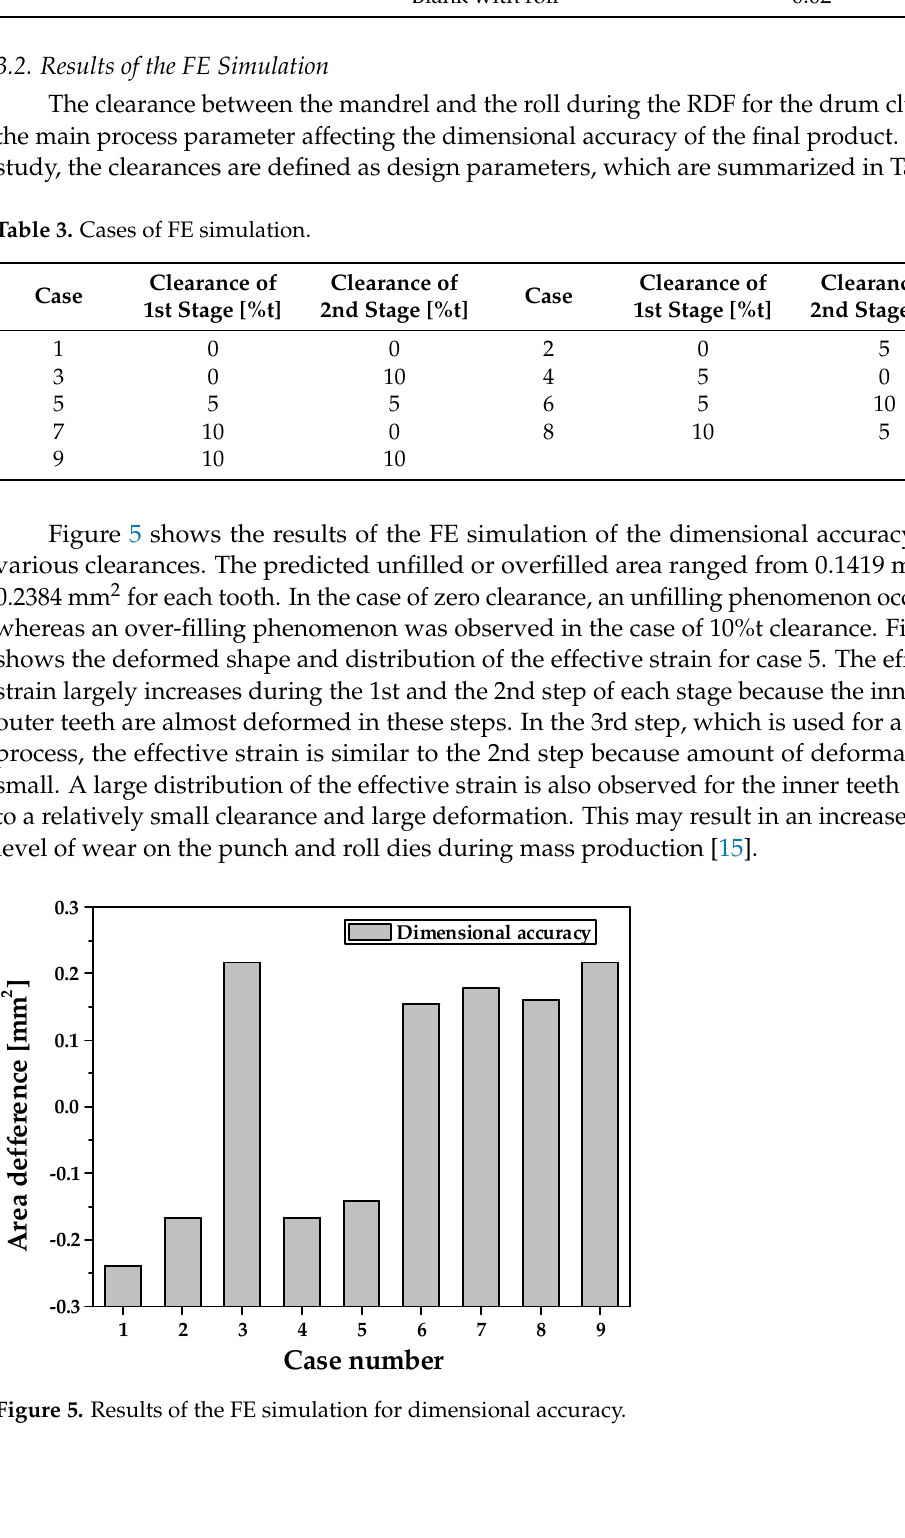
Process Condition Values Material SAPH440